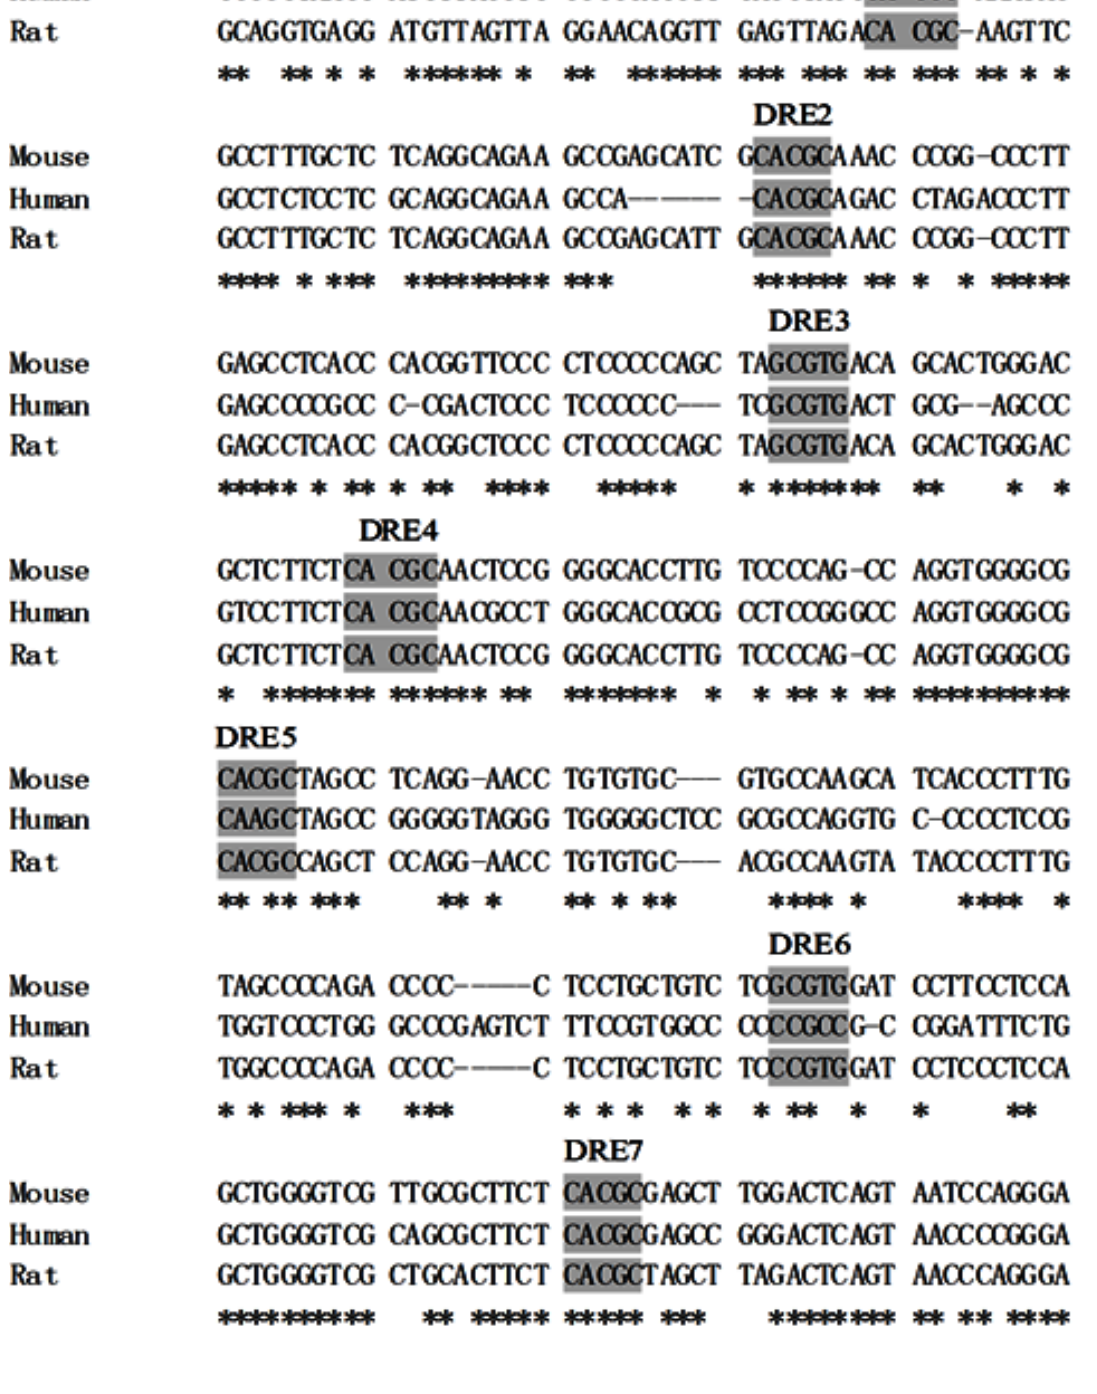
Figure 1. Sequence of the putative dioxin responsive element (DRE) sites on the promoter region of mouse CYP1A1, and the alignments with the corresponding human and rat CYP1A1 promoter sequences are shown. The asterisk “*” indicates positions which have a single, fully conserved